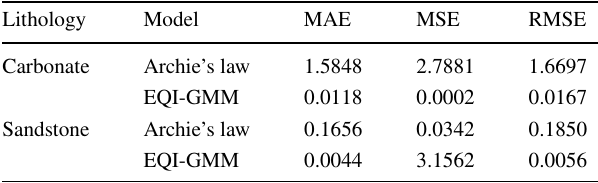
Fig. 7 Log–log plot of formation resistivity factor versus porosity for 64 ERTs with corresponding trendlines on training data from sand- stone samples